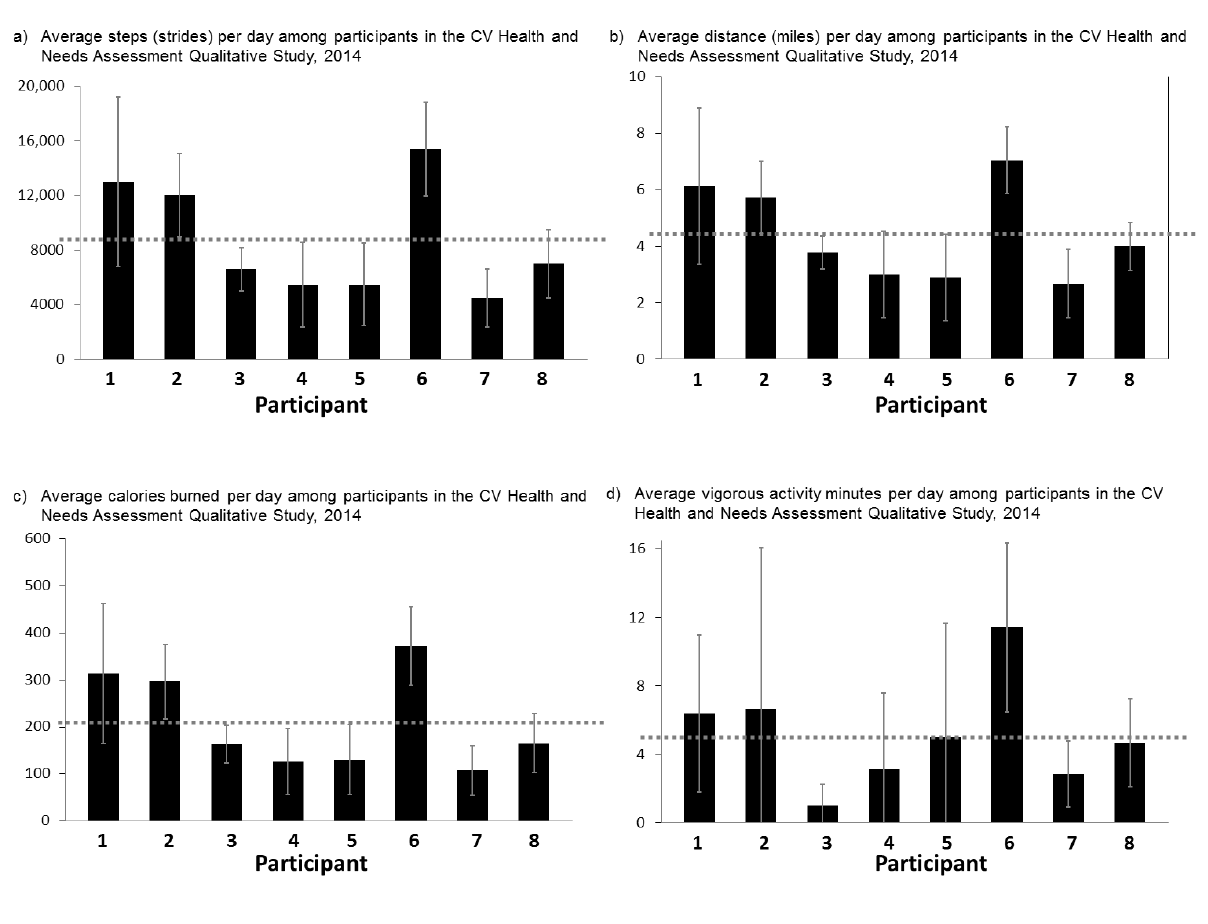
Figure 5. Quantitative participant (n=8) wristband data — Cardiovascular Health and Needs Assessment Qualitative Study, 2014. M=Mean; a) Overall average steps, M(SD) = 8693 (3124) strides per day; b) Overall average distance, M(SD) = 4.40(1.36) miles per day; c) Overall average calories burned, M(SD) = 210(76.6) calories per day; and d) Overall average vigorous activity minutes, M(SD) = 5.13(4.47) minutes per